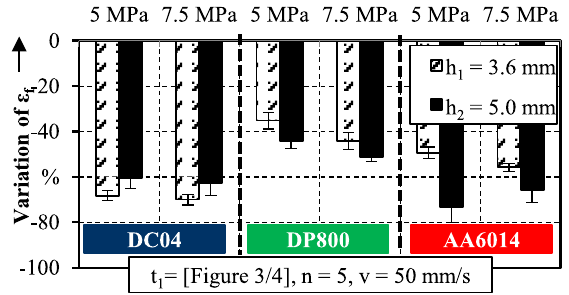
Fig. 14. Modi fi cation of the fracture strain e f in comparison for two drawbead heights and pressure